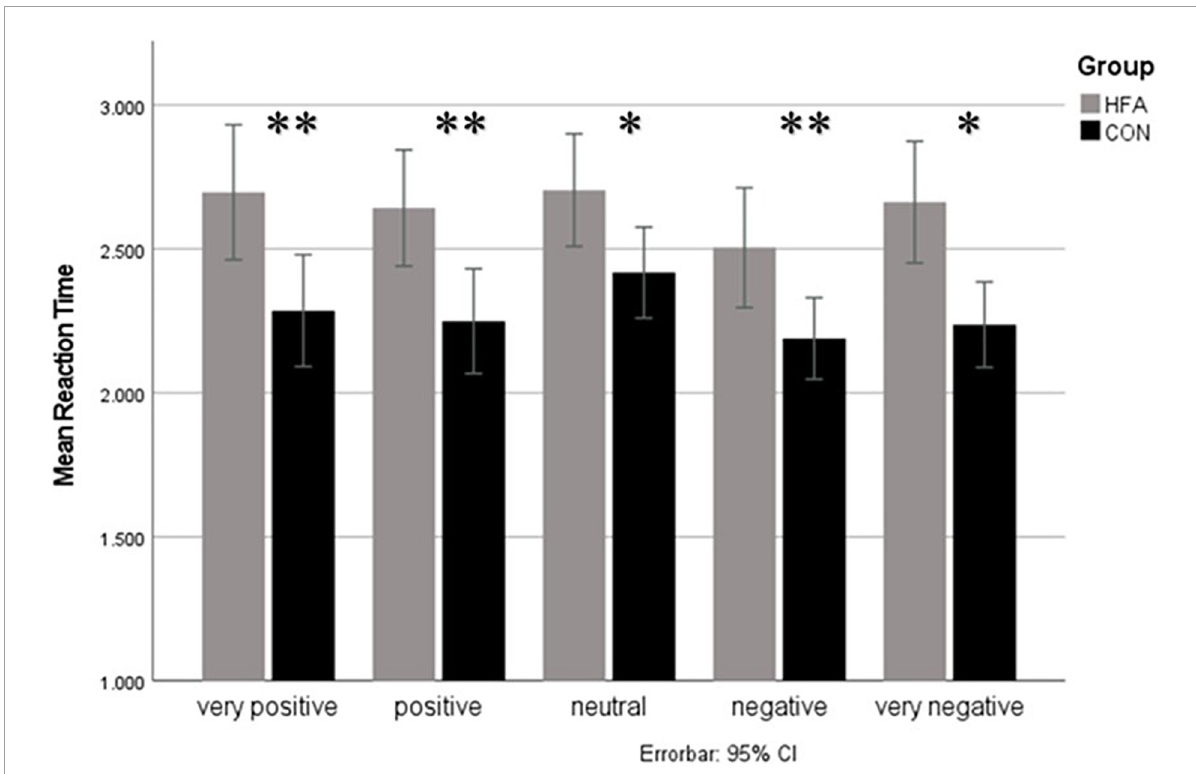
FIGURE3 Response times for different nonverbal valence levels. Mean response time (in ms) for different levels of nonverbal valence on the y -axis. The gray column represents the high-functioning autism (HFA) group, and the black column the typically developed control group. Errorbars indicate 95%-confidence intervals. Significant group differences are indicated by asterisks (level of significance ∗ < 0.05, ∗∗ < 0.01). Significantly slower responses of the HFA group compared to the control group were observed in every valence